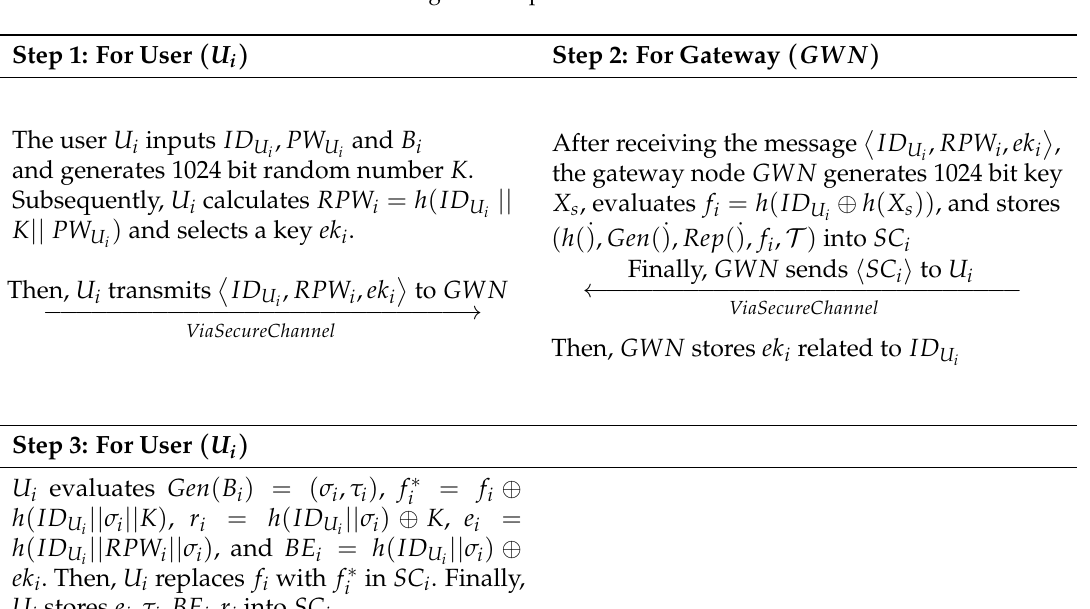
Table 2. User registration phase of A.K.Das’s